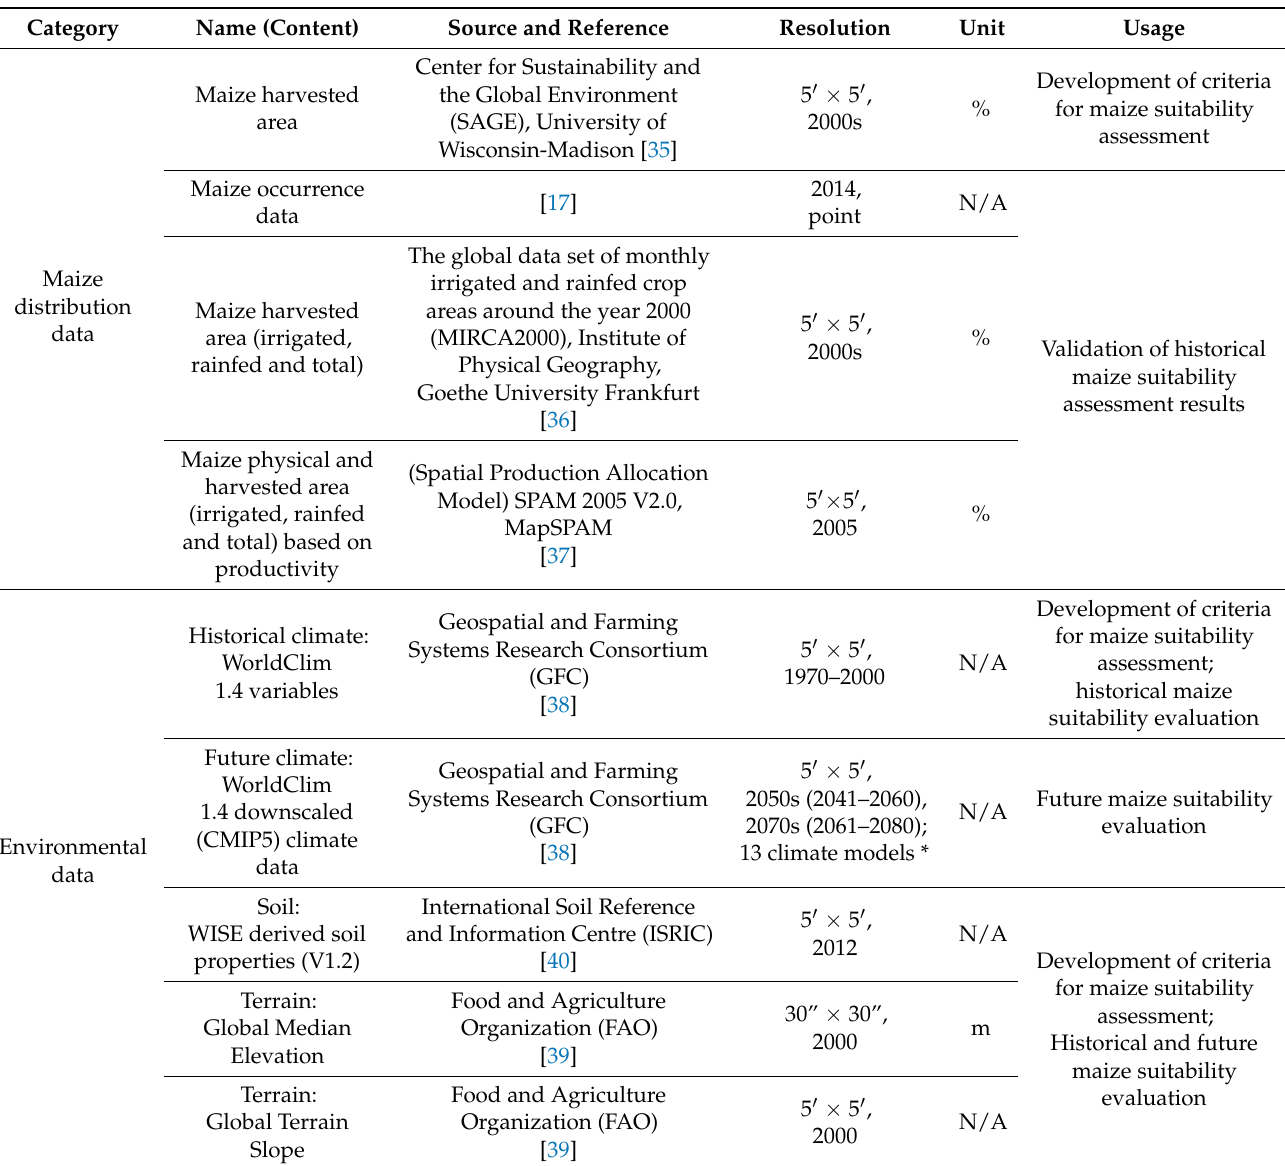
Table A1. List of data employed in this